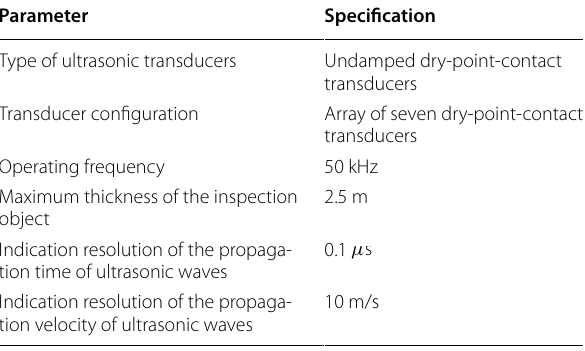
Table 2 Specification of the applied UPV equipment